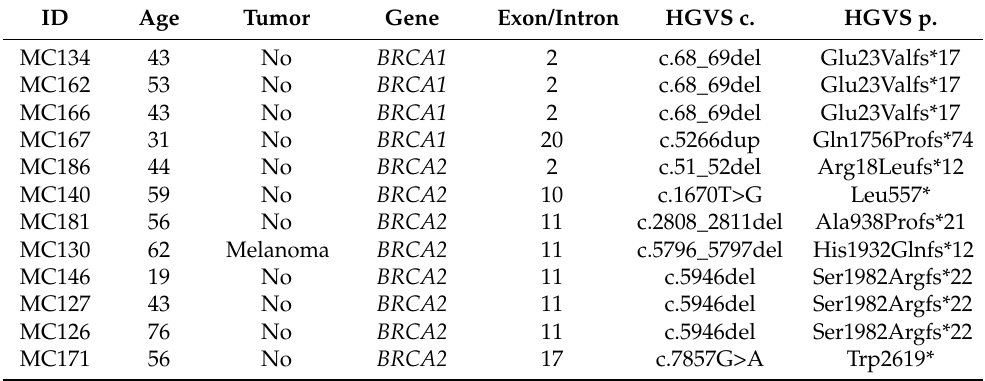
Table 5. Men with pathogenic variants in BRCA1/2; n = 12; age, in years ± SD (range): 48.8 ± 14.9 (19–76).